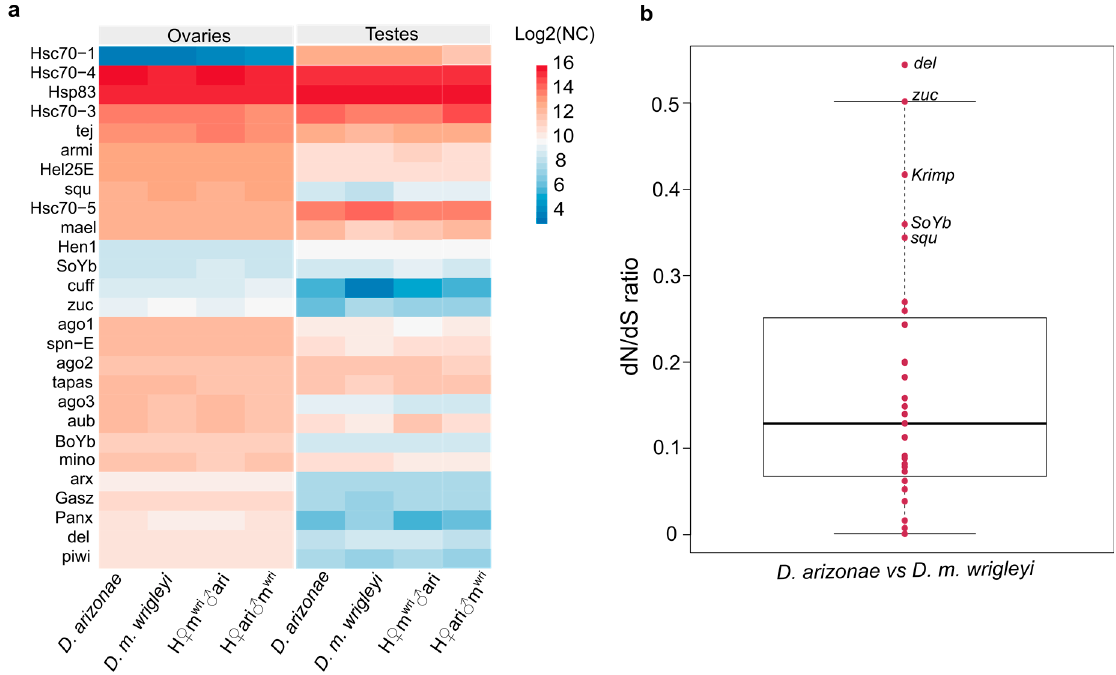
Figure 8. piRNA pathway genes that act in the biogenesis of primary and secondary via piRNAs. ( a ) Heatmap representing gene expression in ovaries (left) and testes (right) of D. arizonae , D. m. wrigleyi, H ♀ m wri ♂ ari and H ♀ ari ♂ m wri . Colors indicate the level of expression according to log2 of normalized counts (NC). ( b ) d N /d S ratio for the 33 genes involved in the piRNA pathway between parental species. The genes under negative relaxed selection (d N /d S > 0.3) for each comparison are identified in the plot.